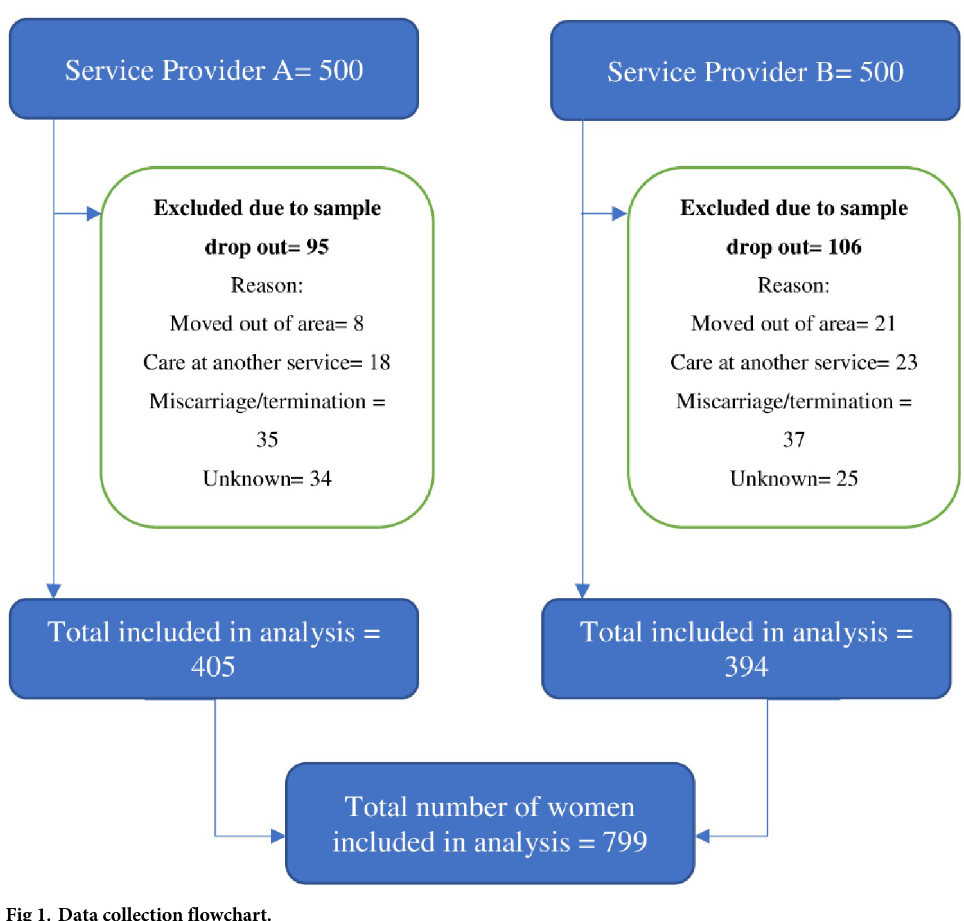
Fig 1. Data collection